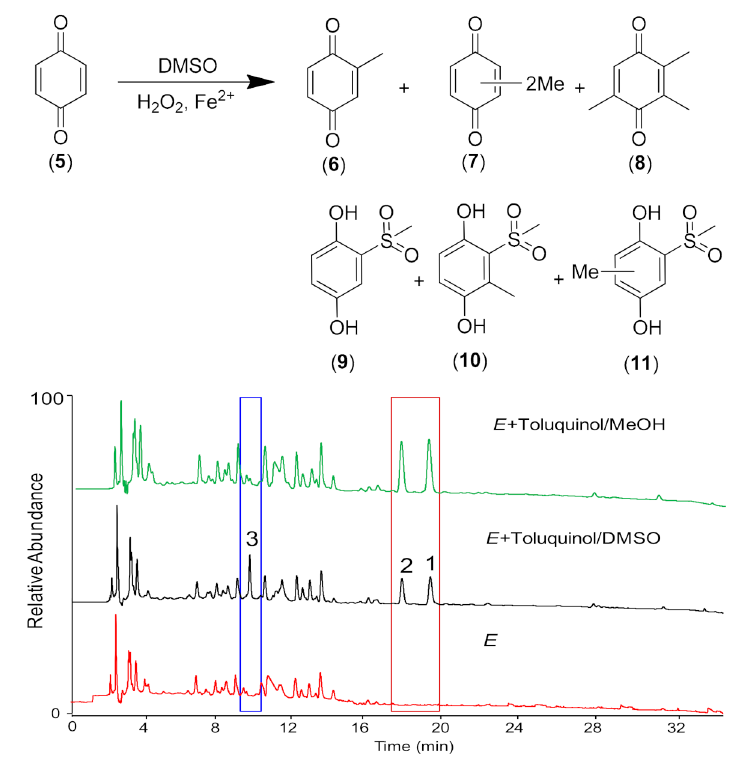
Figure 4. The artificial products ( 6 – 11 ) from benzonquinone ( 5 ) and DMSO via Fenton’ reaction and comparison of metabolic profiles of E. faecalis ( E ) fed with toluquinol in DMSO and